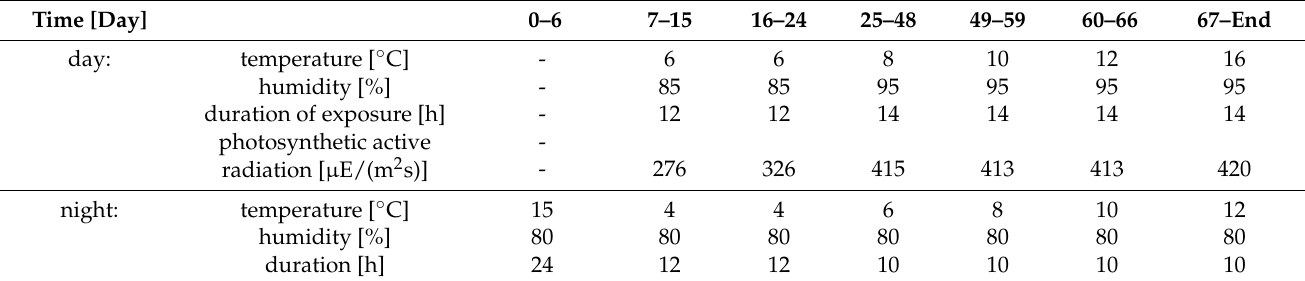
Table 1. Climate chamber program for the cultivation of summer wheat until